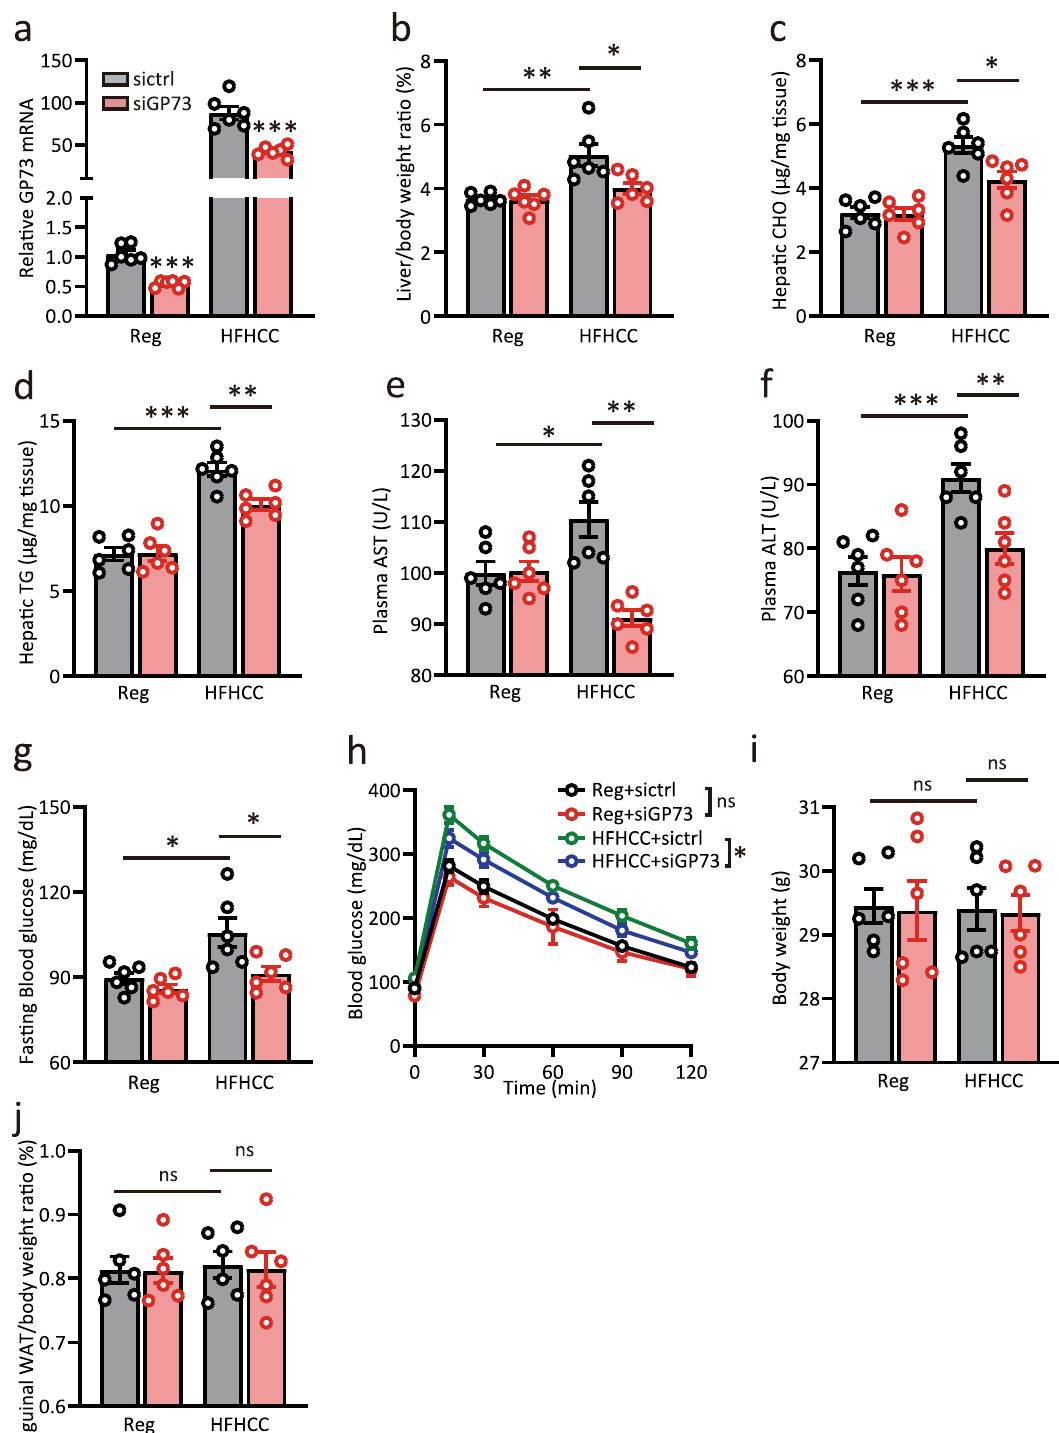
Fig. 8 GP73 blockade improves whole-body metabolism in non-obese NAFLD mouse model. a GP73 mRNA expression in livers from mice fed a regular or HFHCC diet for 1 month and injected with siGP73 or control RNAi oligos twice a week ( n = 6 per group). Differences between the two groups were evaluated using unpaired Student ’ s t -test. Data are presented as mean ± SEM. *** P < 0.001. b – j Liver-to-body weight ratio ( b ); hepatic levels of CHO ( c ) and TGs ( d ); plasma levels of AST ( e ) and ALT ( f ); fasting glucose levels ( g ) and GTT ( h ); body weight ( i ) and inguinal WAT-to-body weight ratio ( j ) in the four groups above ( n = 6 per group). Differences between two groups were evaluated using unpaired Student ’ s t -test. Data are presented as mean ± SEM. ns, no statistical signi fi cance; * P < 0.05; ** P < 0.01; *** P <